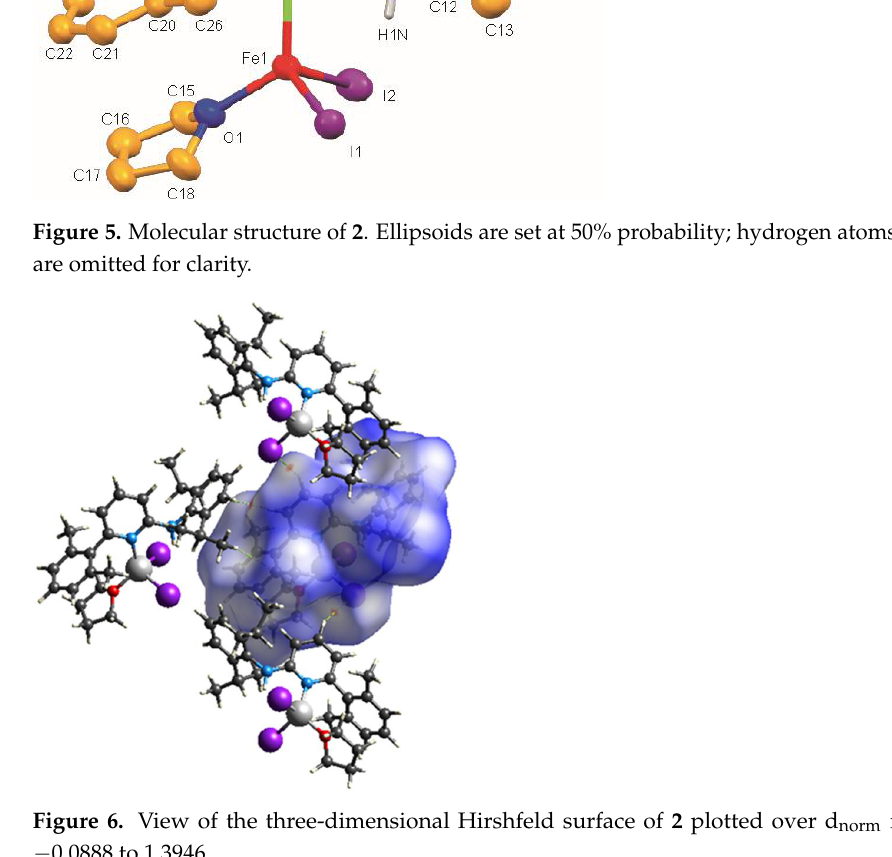
Figure 5. Molecular structure of 2 . Ellipsoids are set at 50% probability; hydrogen atoms except N-H are omitted for clarity.